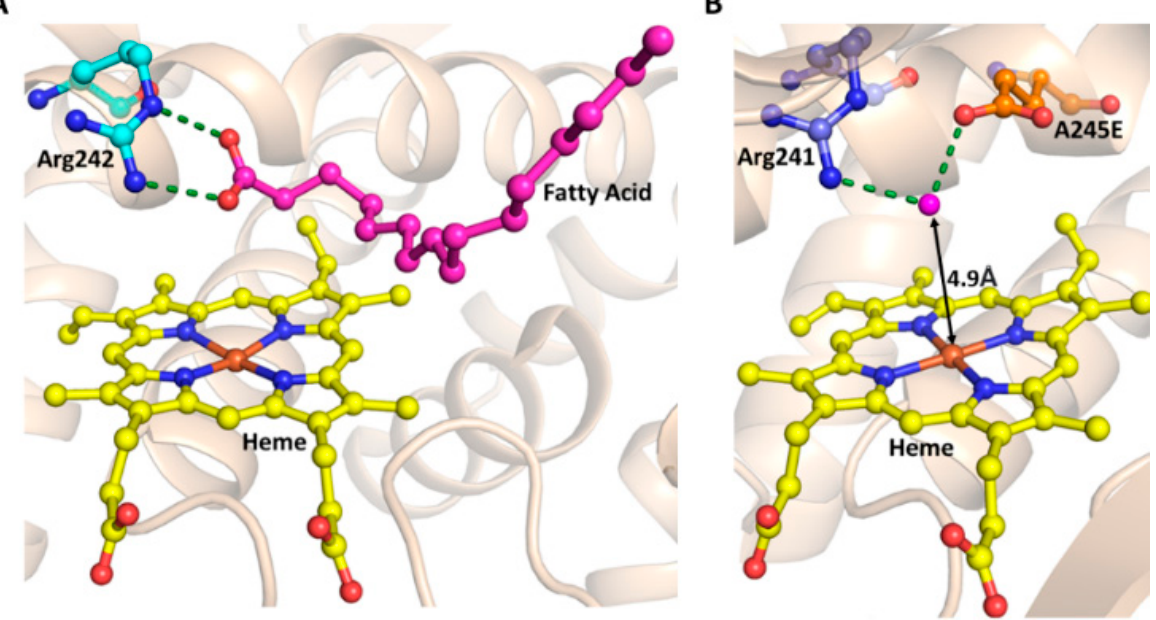
Figure 6. Role of the substrate and the acid-base pair in H 2 O 2 -dependent peroxidation by P450 enzymes. ( A ) Salt-bridge formation between Arg242 (cyan sticks) and Fatty Acid (magenta sticks) in P450BS β (PDB ID: 1IZO). ( B ) Rationally engineered acid-base pair in P450SP α . The variant was engineered by A245E substitution. Interactions of E245 (orange sticks) with Arg241 (cyan sticks) are represented in broken green lines (PDB ID: 3VOO). The heme prosthetic group is shown with yellow stick representation.